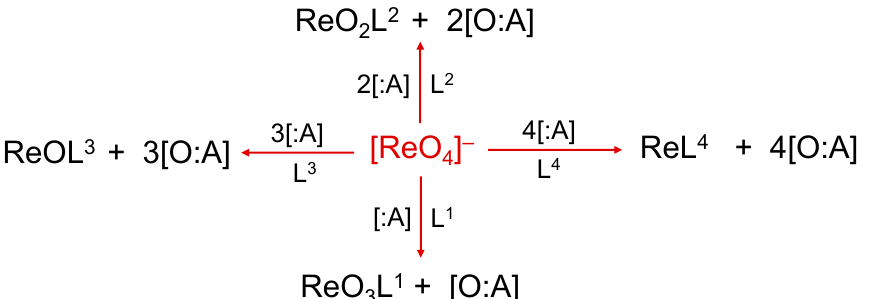
Figure 1. Oxygen atom transfer reactions using [ 188 Re]perrhenate as starting substrate. The symbol ‘:A’ represents the oxygen-atom acceptor and L n ( n = 1–4) the ligand (or multiple ligands) suitable to form a stable complex with one of the various intermediate Re-oxo forms. Examples of :A are SnCl 2 or tertiary phosphines.